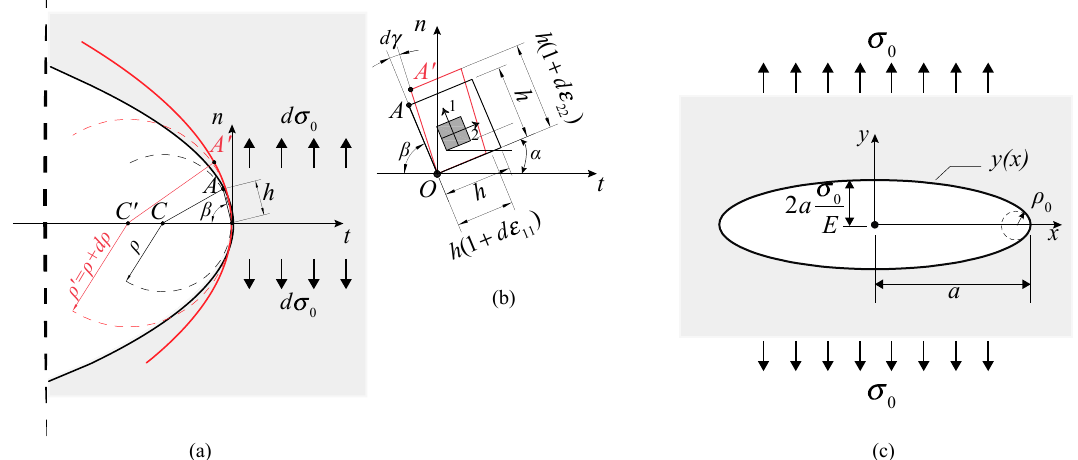
Figure 10. ( a ) Model of notch blunting. Schematic of the notch profile modification due to the large strains occurring in the material during an increment of the remote stress d σ 0 . The radius of curvature at point A (undeformed) and A’ (deformed) is shown. ( b ) Deformation of a small material element in the vicinity of the notch root. ( c ) Elliptical notch, with the equivalent semi-axes obtained from the crack flank displacement under tensile stress σ 0 .